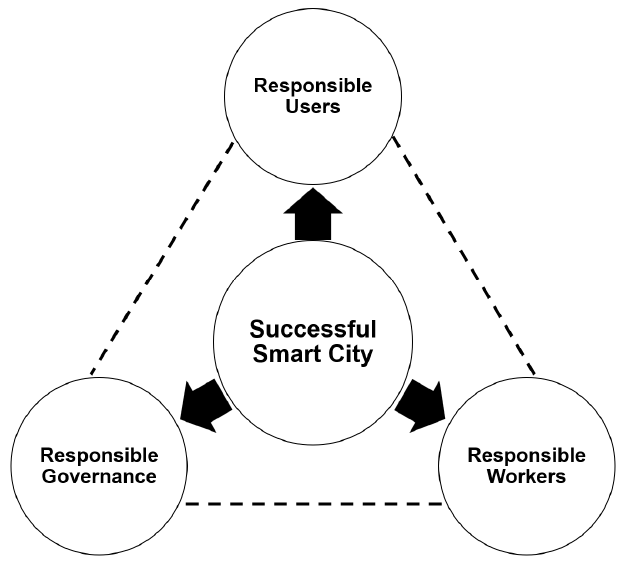
Figure 18. The golden triangle for the success of a smart city.